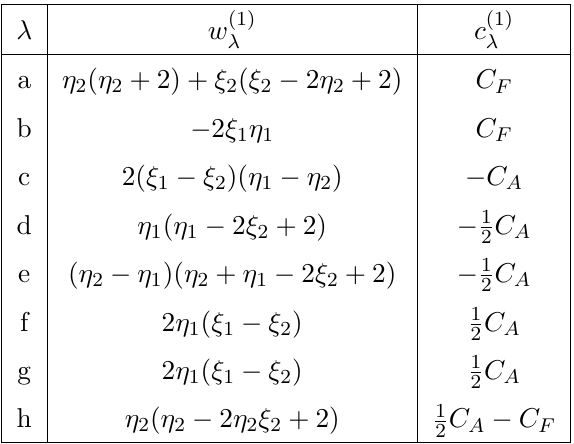
is determined by the diagrams in (cid:12)gures 6(d,e) with the corresponding exponential